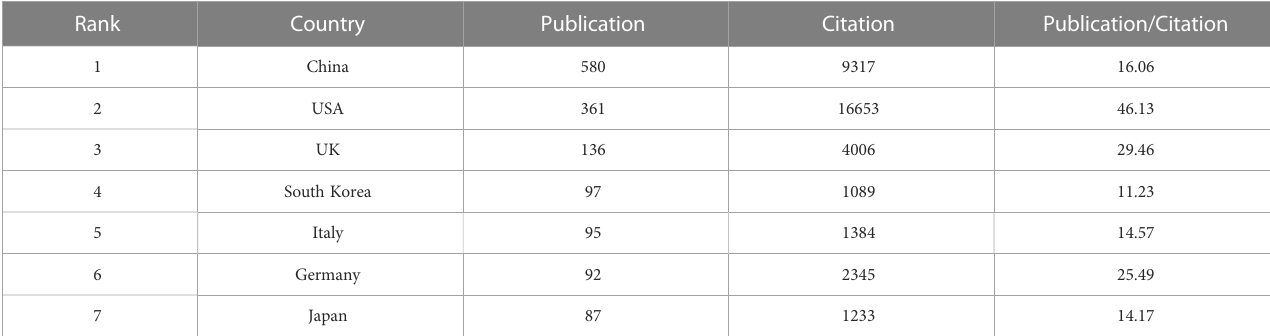
TABLE 1 Top 7 productive countries/regions related to AI in CRC.